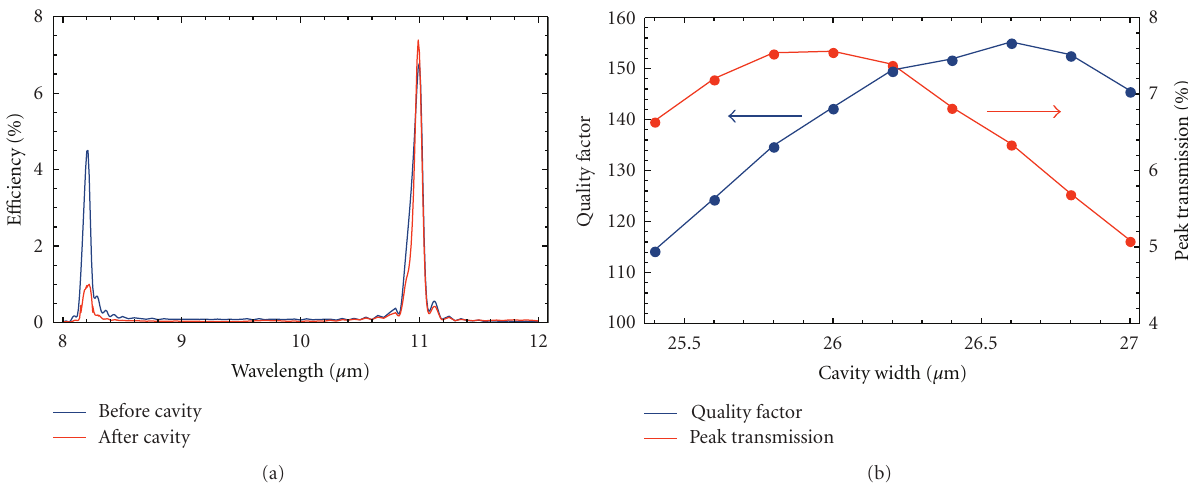
Figure 4: (a) Spectra before and after including a 26.2 μ m waveguide cavity. Coupling e ffi ciency into the waveguide is plotted for “before cavity” and transmission is plotted for “after cavity.” (b) Dependency of quality factor and peak transmission on the waveguide cavity width. Parameters used: grating parameters same as above, w cap = 26 . 2 μ m, Λ C = 4 . 4 μ m, d C = 500nm, t ZnSe,1 = 1 . 1 μ m, t cap = 100nm, N C = 4.